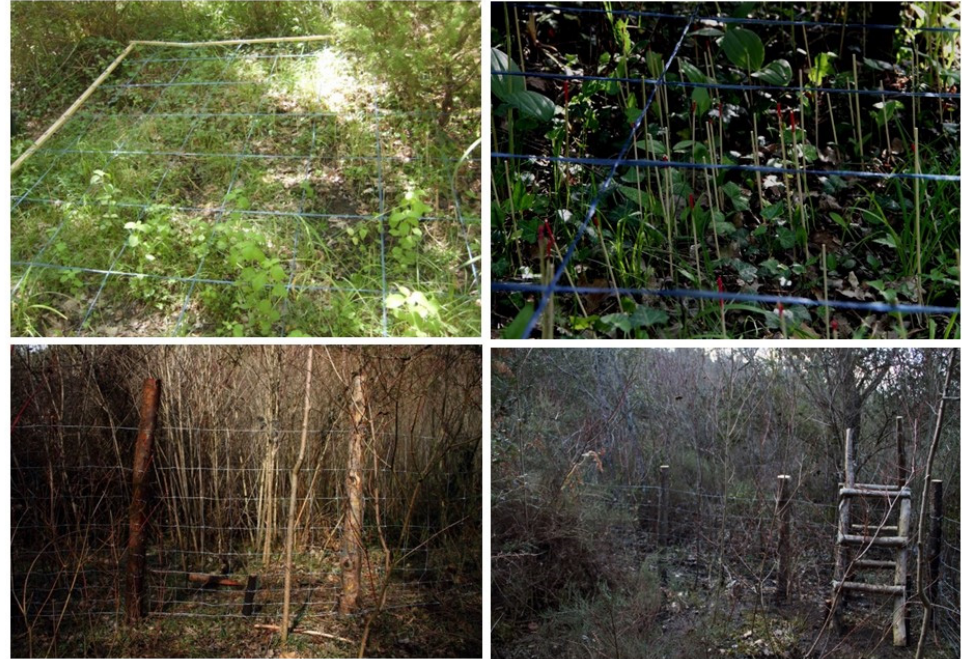
Figure 4. Monitoring protocol using a fixed grid to map each individual plant and different woody stock to distinguish juvenile and mature plants (up); fence protection for the population of Ophioglos- sum vulgatum at Funtanamela, Laconi (Photo by Giuseppe Fenu and Carlo Dess ì